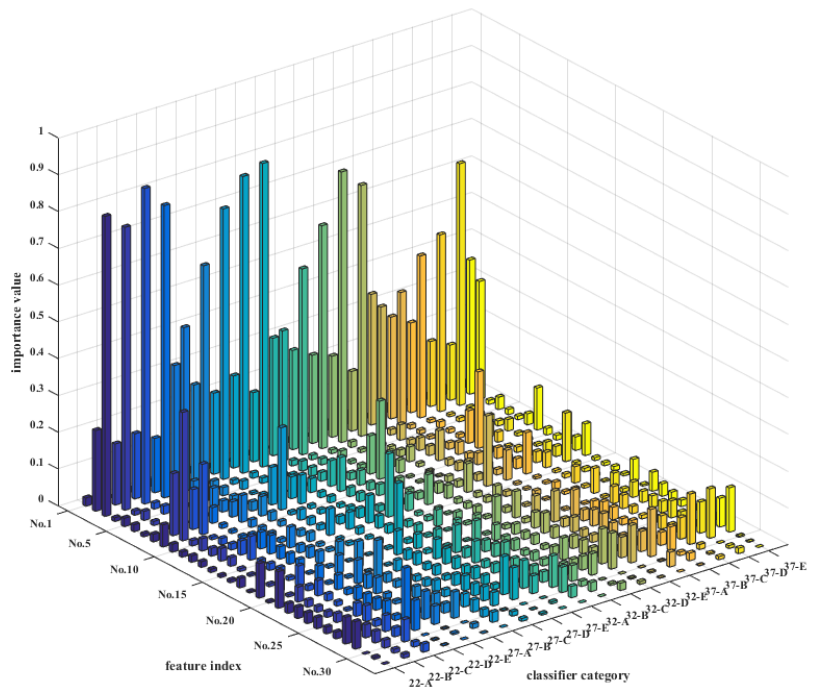
Figure 8. Importance values of 32 feature candidates for 20 classifier models. Axis x is the categories of a bagged tree model, e.g., 22-A is the bagged tree model trained for sequences in QP 22 and resolution class A. Axis y represents features whose serial number is the corresponding index in Table 1, e.g., feature of No. 15 is